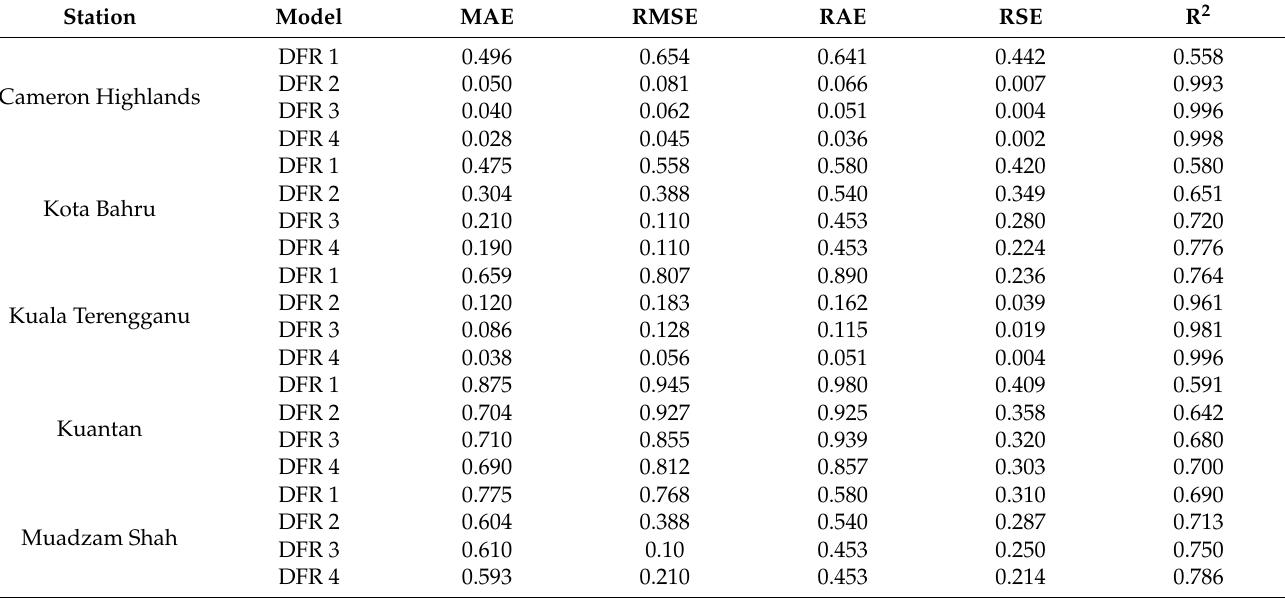
Table 3. Statistical evaluation of DFR model with different meteorological variables for testing